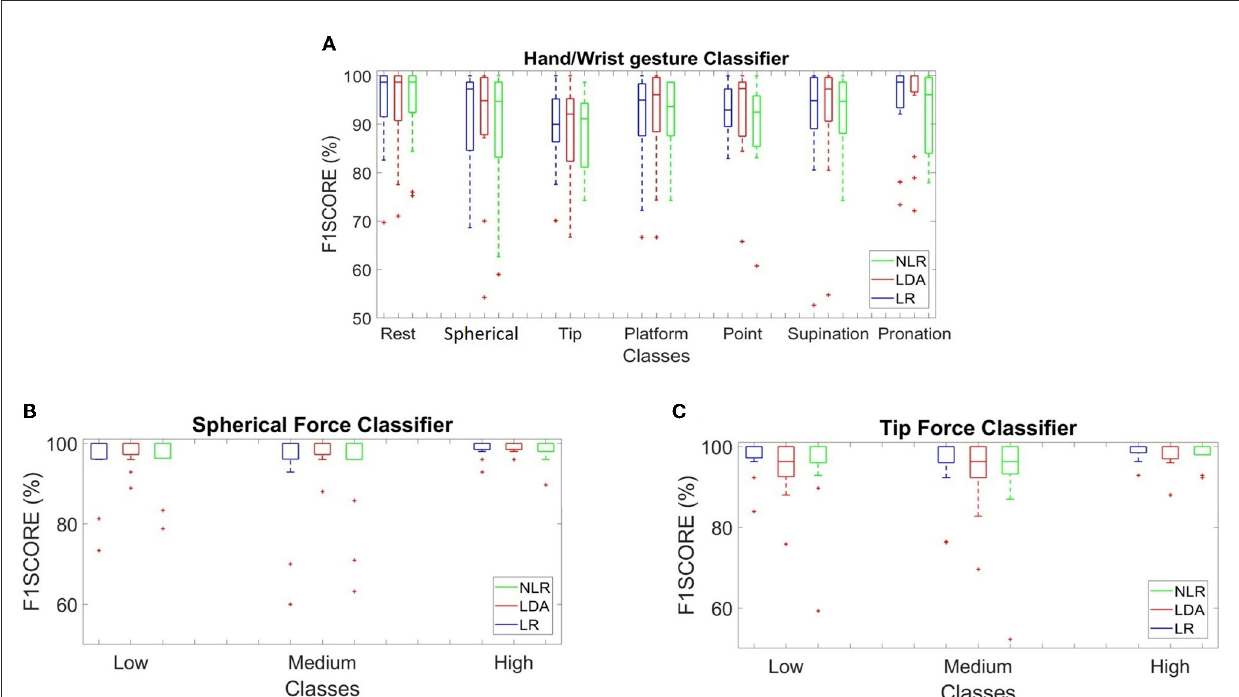
FIGURE4 (A–C) Average F1 score values calculated for 15 transradial amputees using the LR (in blue), LDA (in red), and NLR (in green) algorithms, tested on the “test set” with the five time-domain features extraction (FE) step for the “hand/wrist gestures classifier” (the F1 Score of the seven hand/wrist gestures classes have been reported) (A) , the “spherical force classifier” (B) , and the “tip force classifier” algorithm (C) . The F1Score values of the three force levels have been shown. No statistically significant differences based on a U -test with Bonferroni correction among classes were found for the LR, LDA, and NLR